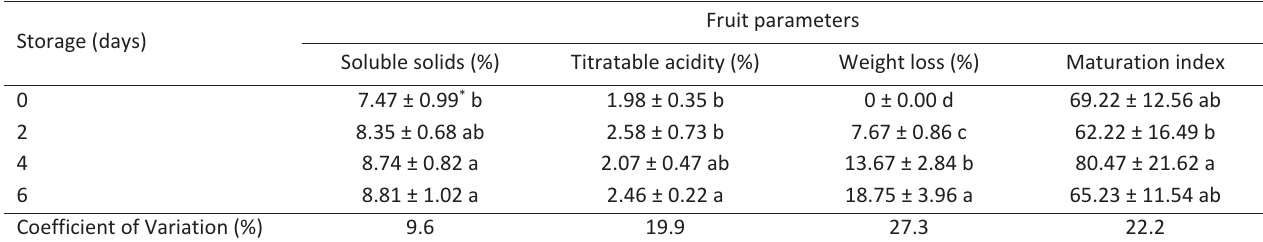
* Standard deviation. Values followed by the same lowercase letter in a column are not significantly different from each